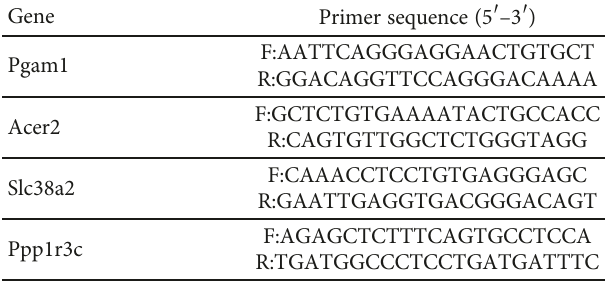
Table 1: List of primers used in RT-qPCR. Gene Primer sequence (5 ′ – 3 ′